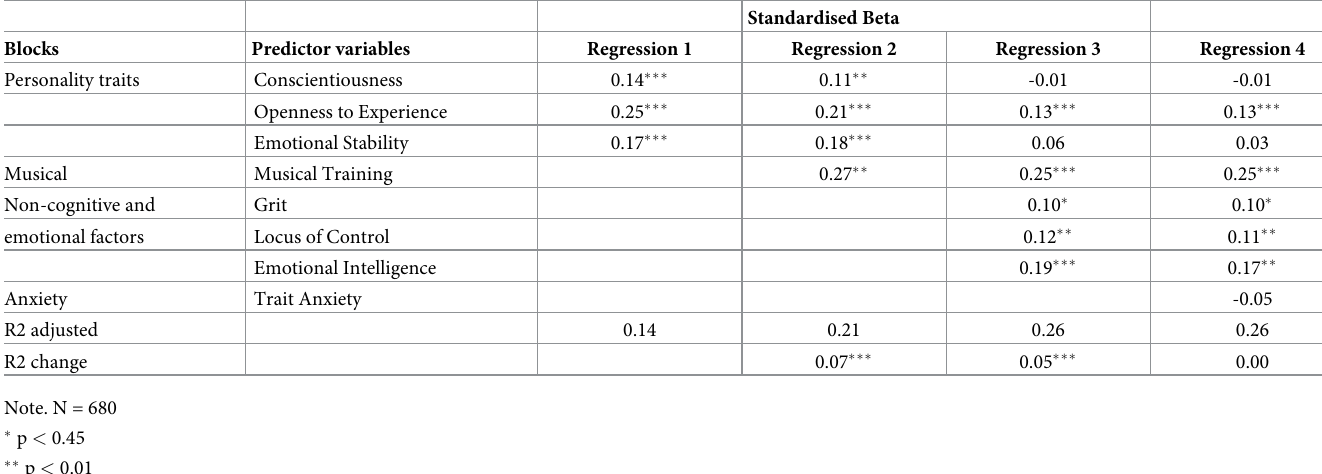
Table 5. Hierarchical regression predicting flow proneness including various known predictors and trait